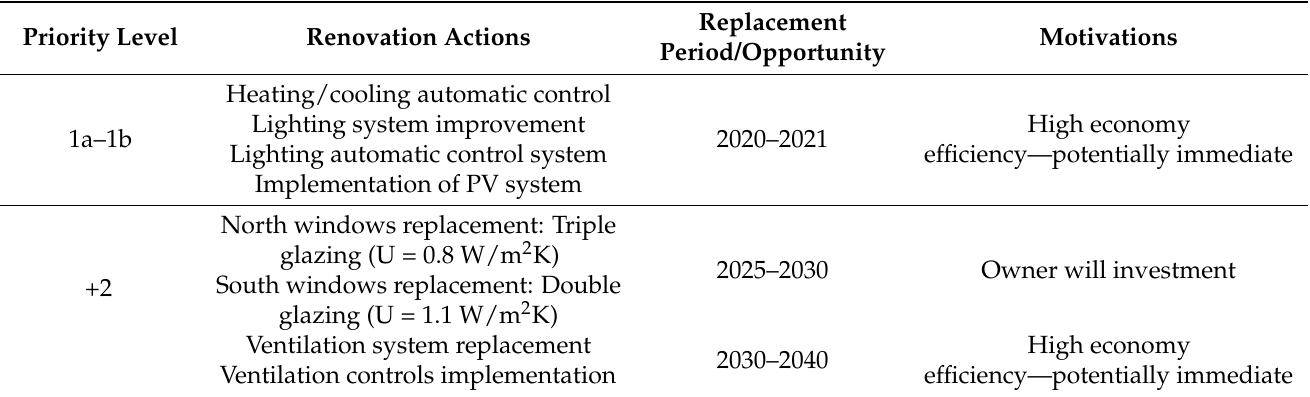
Table 11. Identification of the ERAs sets for Building 8, Politecnico di Milano—Lecco Campus, by priority level defined according to owner wills and technical